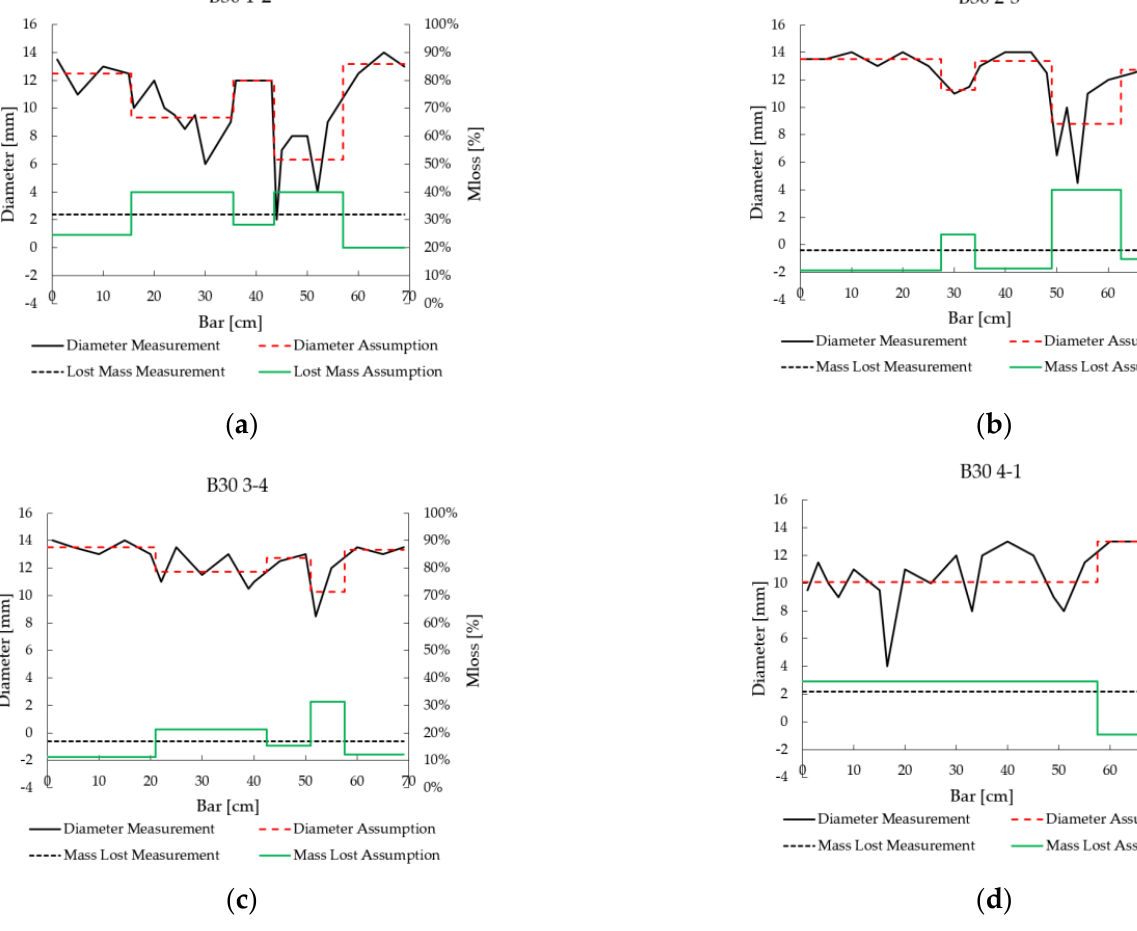
Figure 10. Assumptions for corroded bars (modelling strategies 3 and 4) compared with original measurement, Specimen B30. ( a ) Bar 1-2, ( b ) Bar 2-3, ( c ) Bar 3-4, ( d ) Bar 4-1.